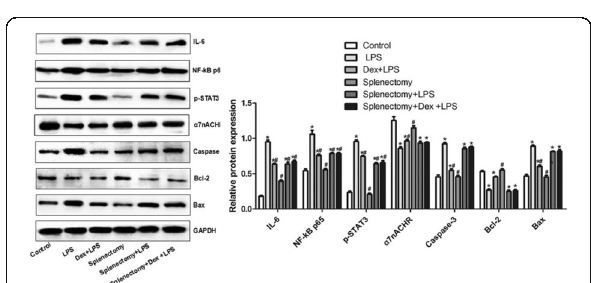
Fig. 6 (abstract 000504). IL-6, NF-kB p65, p-STAT3, α 7nACHR, Caspase-3, Bcl-2 and Bax expression in different groups (*P<0.05 vs. Control; #P<0.05 vs.